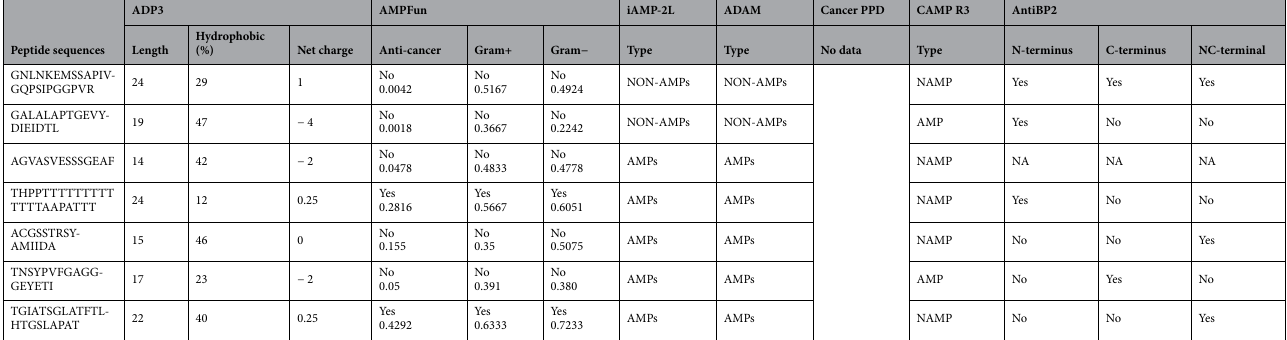
Table 1. Details on bioinformatics prediction of antimicrobial peptides from